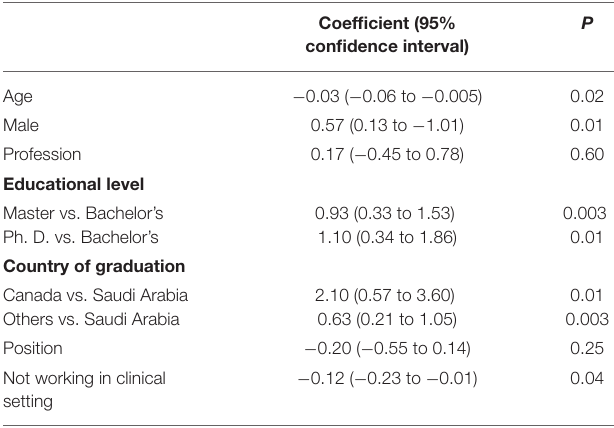
TABLE 4 | Linear regression analysis for factors affecting knowledge score ( n = 419).